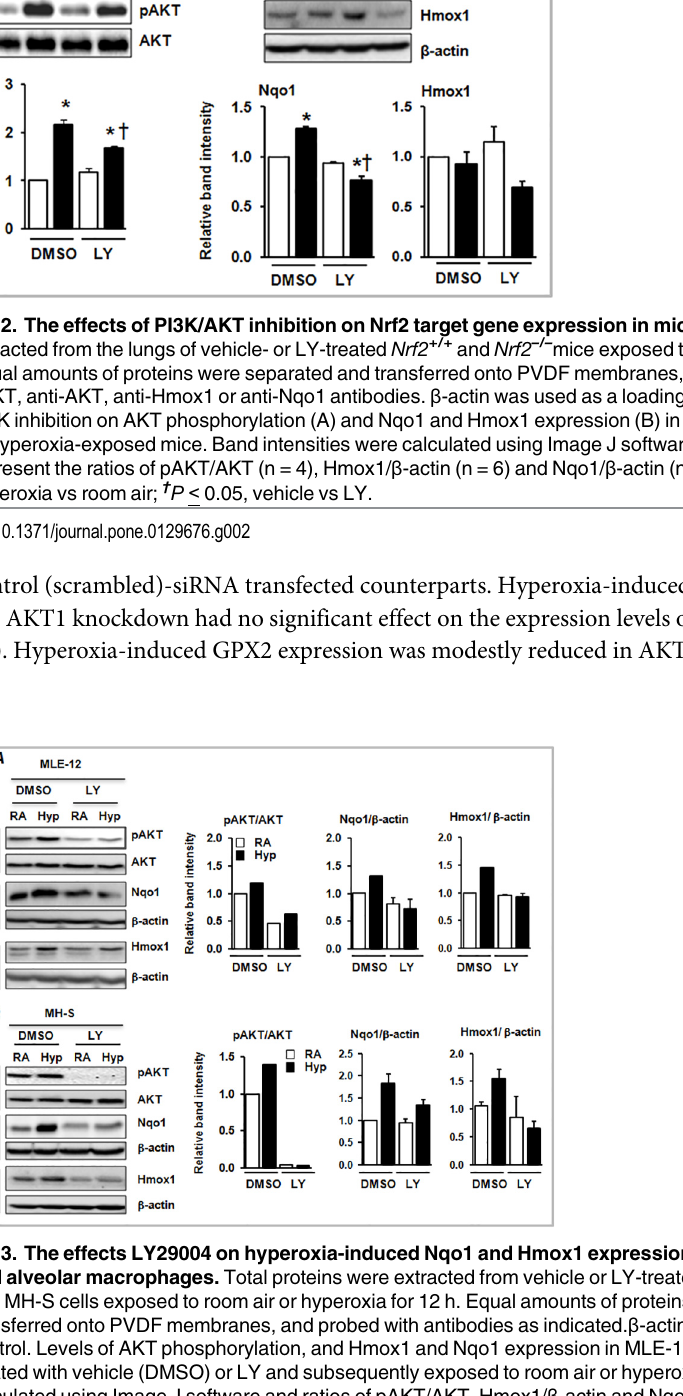
Fig 3. The effects LY29004 on hyperoxia-induced Nqo1 and Hmox1 expression in lung epithelial cells and alveolar macrophages. Total proteins were extracted from vehicle or LY-treated MLE-12 and MH-S cells exposed to room air or hyperoxia for 12 h. Equal amounts of proteins were separated and transferred onto PVDF membranes, and probed with antibodies as indicated. β -actin was used as a loading control. Levels of AKT phosphorylation, and Hmox1 and Nqo1 expression in MLE-12 (A) and MH-S (B) cells treated with vehicle (DMSO) or LY and subsequently exposed to room air or hyperoxia. Band intensities were calculated using Image J software and ratios of pAKT/AKT, Hmox1/ β -actin and Nqo1/ β -actin. pAKT/AKT levels shown are from a representative experiment. Relative band intensities of Nqo1 and Hmox1 are from two independent samples (n =